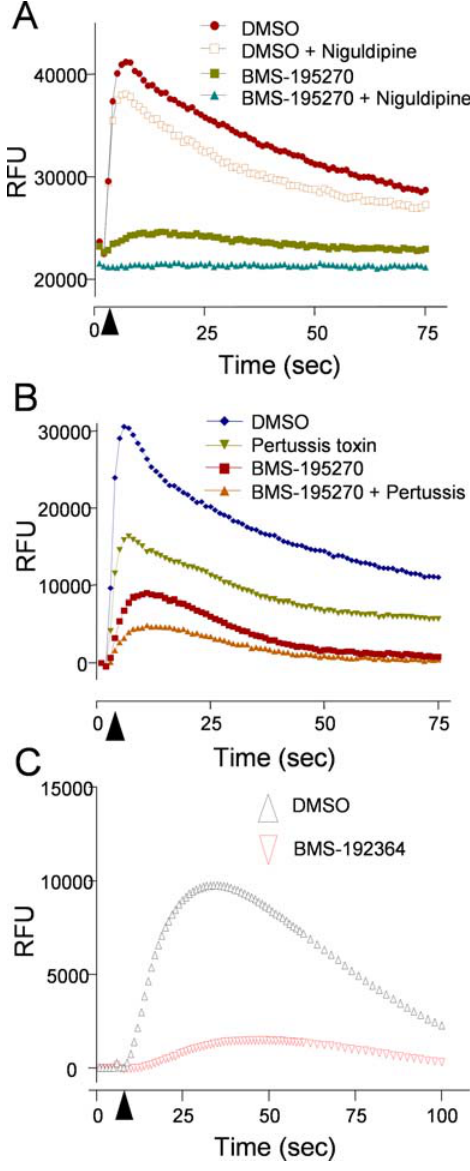
Figure 7. Effect of BMS-192364 in Combination with Other Modulators of Calcium Signaling The graphs display fluorescence intensity measurements for HEK293 cells preloaded with Fluo-4 then stimulated with the muscarinic GPCR agonist carbachol at 100 l M. Five baseline fluorescence measurements were taken prior to the injection of carbachol. Where indicated, BMS-195270 or BMS-192364 (100 l M) were added 15 min prior to the carbachol stimulation. The timing of carbachol addition is indicated by a black arrowhead. (A) Where indicated, cells were pre-incubated for 15 min with the calcium channel blocker niguldipine (100 l M). (B) Where indicated, cells were pre-incubated for 24 h with the G-protein antagonist pertussis toxin (150 ng/ml). (C) The treated cells are overexpressing the G- a q mutant allele G188S, which is known to be insensitive to RGS GAP activity. DOI: 10.1371/journal.pgen.0020057.g007